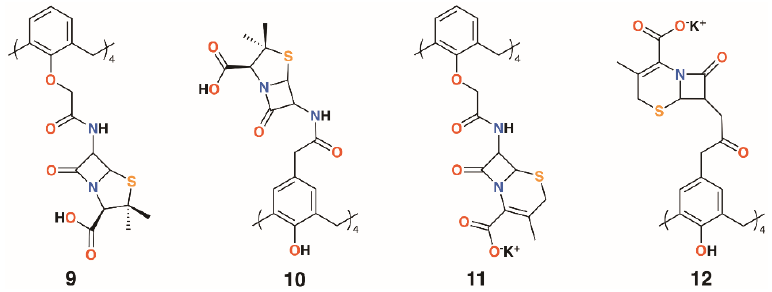
Figure 5. Dillmaghani’s calixpenams and